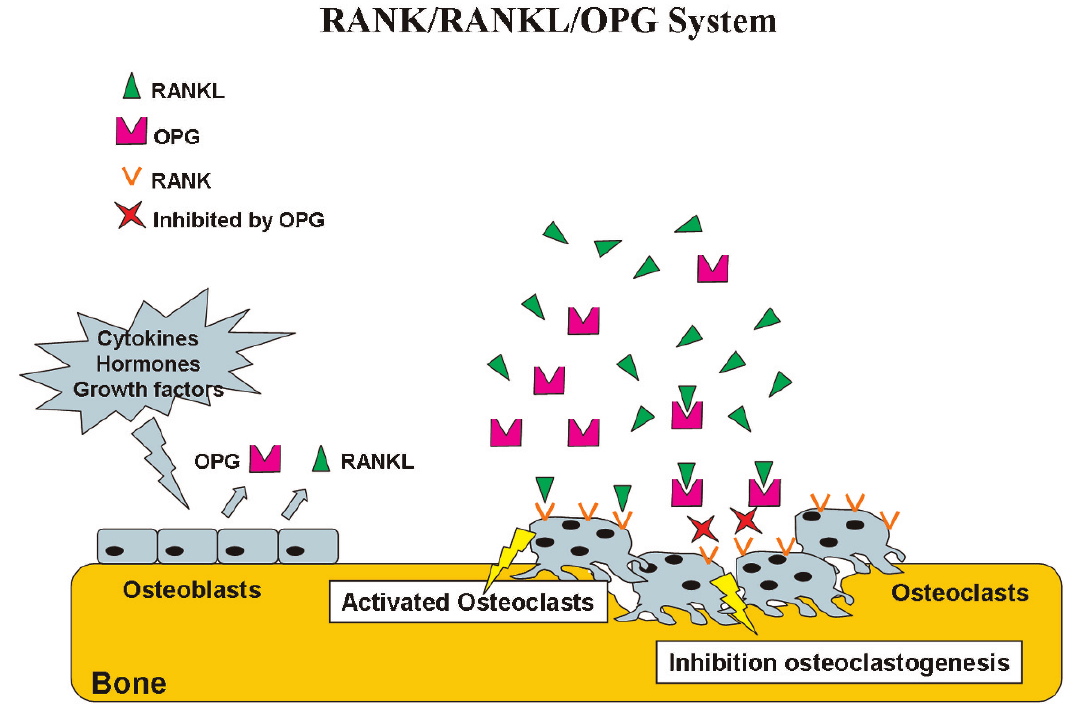
Figure 1 - RANK/RANKL/OPG system. Osteoblasts produce RANKL and OPG under the control of various cytokines, hormones, and growth factors. OPG binds and inactivates RANKL, resulting in the inhibition of osteoclastogenesis. In the absence of OPG, RANKL activates its receptor, RANK, expressed on osteoclasts and preosteoclast precursors. The RANK-RANKL interaction leads to preosteoclast recruitment and fusion into multinucleated osteoclasts and to osteoclast activation and survival. bone mass, such as parathyroid hormone (PTH) peptides, strontium ranelate (SR) and anti-Dickkopf-related protein 1 (DKK1) and anti-sclerostin (SOST) antibodies (Figure 2 and Table 1).